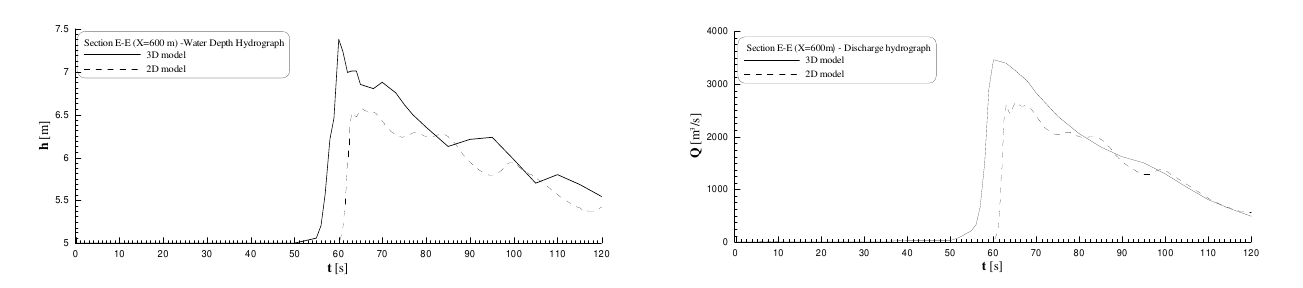
Fig. 7. Water Depth hydrograph at E-E Section (x=600). Fig. 8. Discharge hydrograph at E-E Section (x=600).